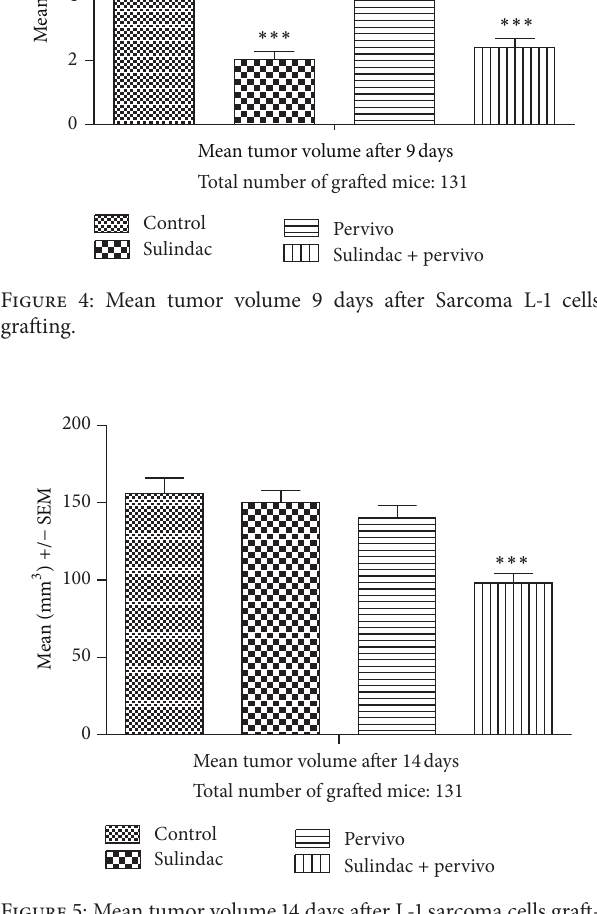
Figure 5: Mean tumor volume 14 days after L-1 sarcoma cells graft- ing ∗∗∗ 𝑃 < 0.001